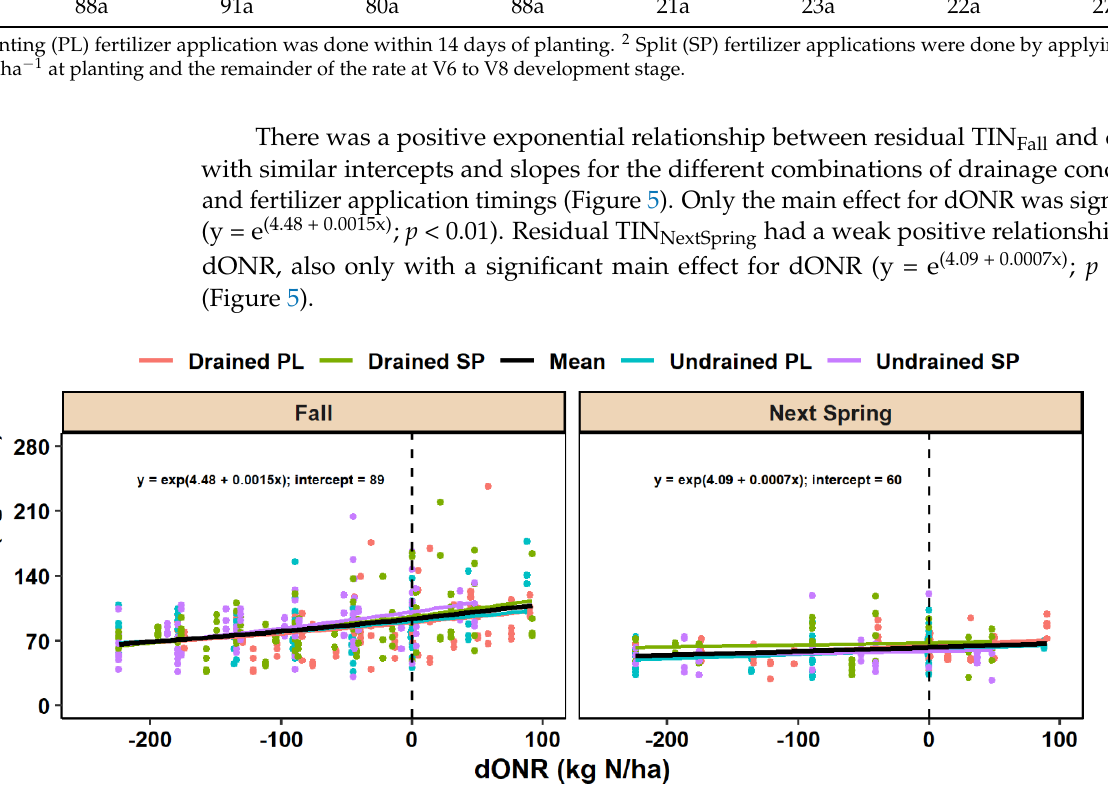
Figure 5. Residual total inorganic nitrogen (TIN (NO 3 − -N plus NH 4+ -N)) measured from 0 to 90 cm soil depth in the fall or the next spring from 2014 to 2019, as related to nitrogen rate differential from ONR (dONR) in drained and undrained soils for the at-planting (PL) and split (SP) fertilizer application timings and mean regression equation. The regression equations for the different combinations of drainage conditions and fertilizer application timings are not statistically different from one another ( p >